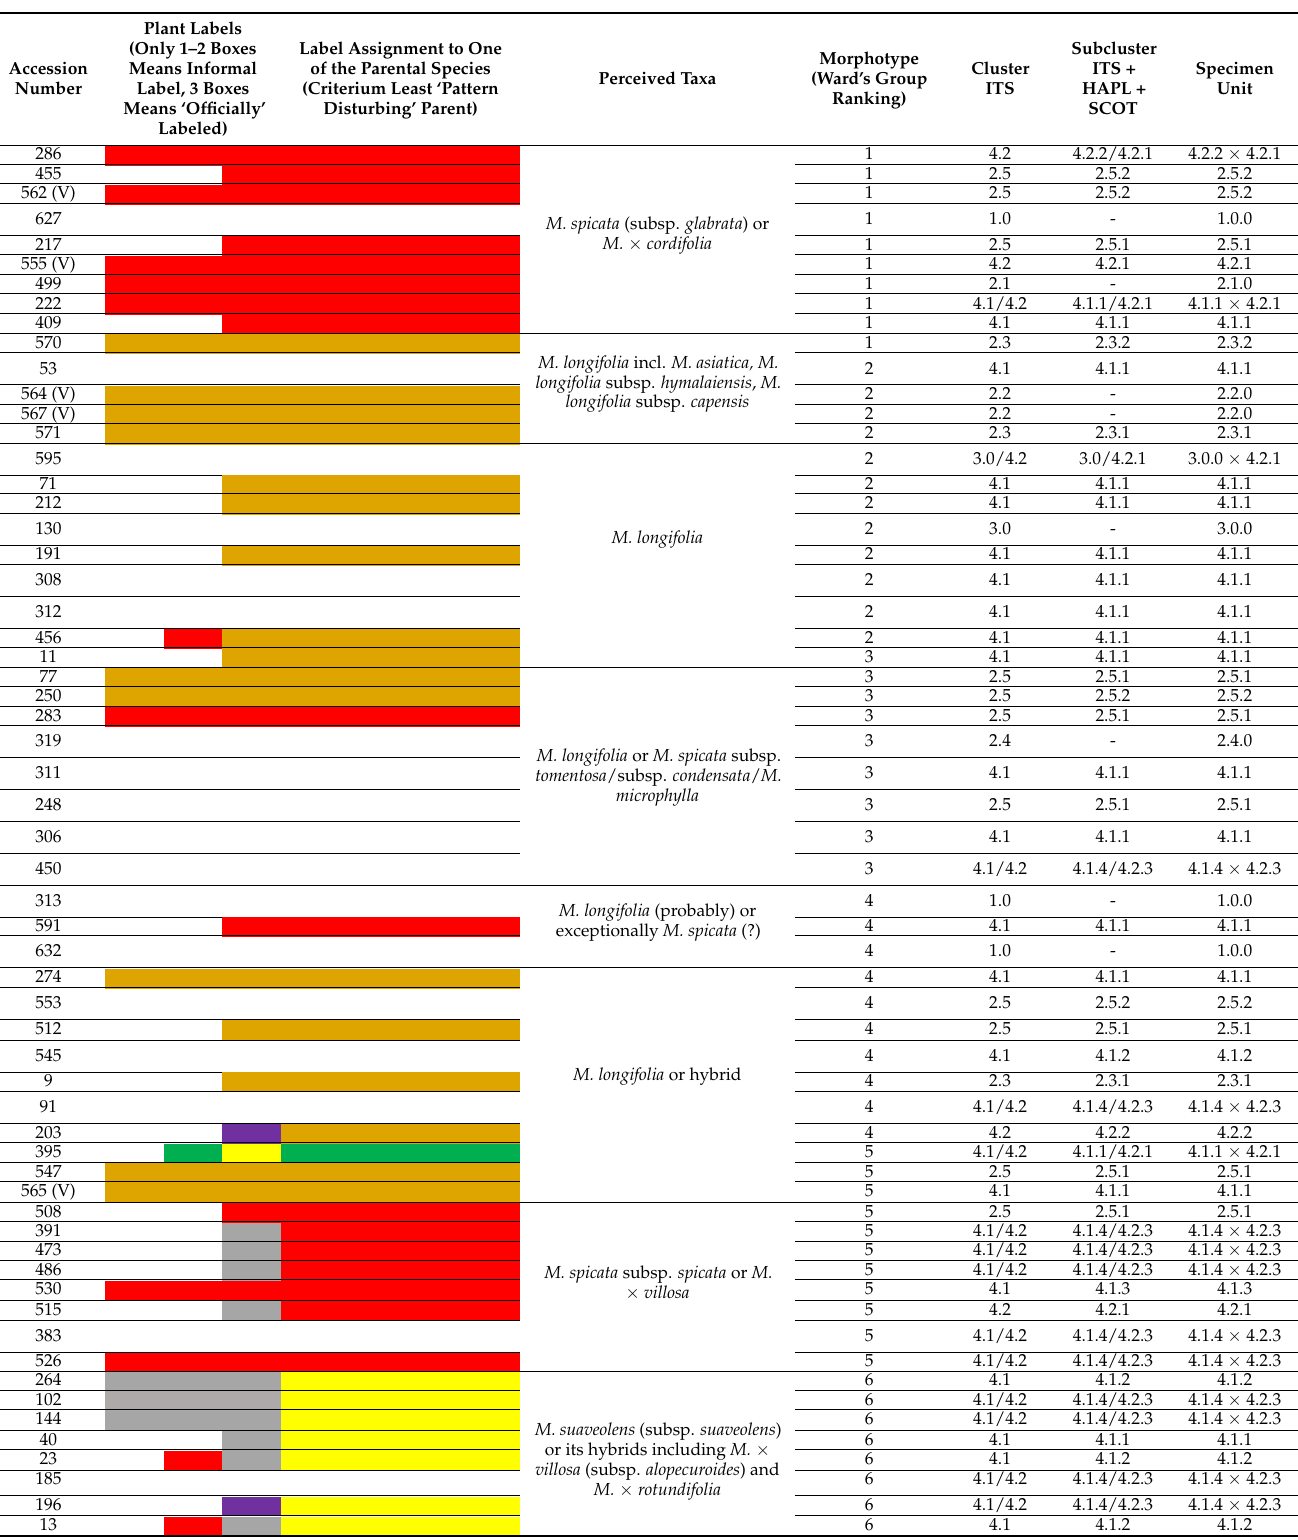
Table 1. Correspondence of Ward’s groups and traditional cryptic species perceptions using plant labels. Blocks coded by Ward’s groups are presented with genetic (sub)cluster codes and corresponding specimen units (plants). Ward’s groups can be compared to the available set of plant labels, accepting that for hybrid samples parent selection is done with the one parent most fitting the category becoming selected (‘label assignment’). Additionally, some explanation is given about the plant names as traditionally used. Color legend: see Figure